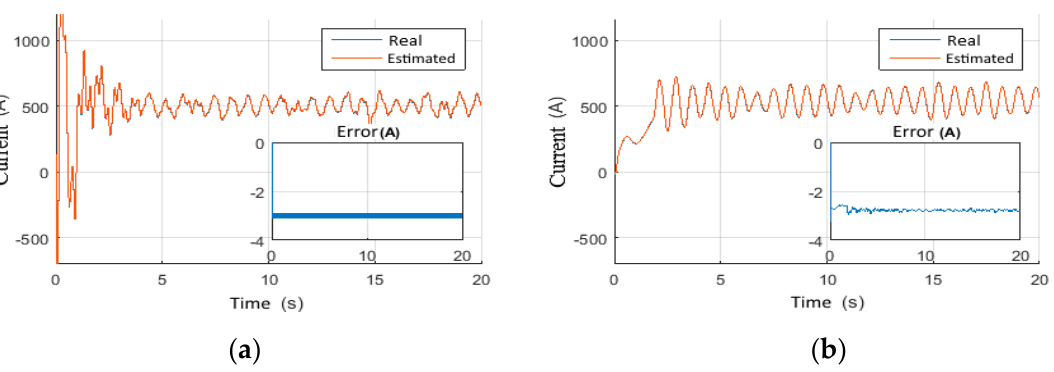
Figure 40. Real and estimated Torque on bit under: ( a ) LQG controller, ( b ) H ∞ controller.